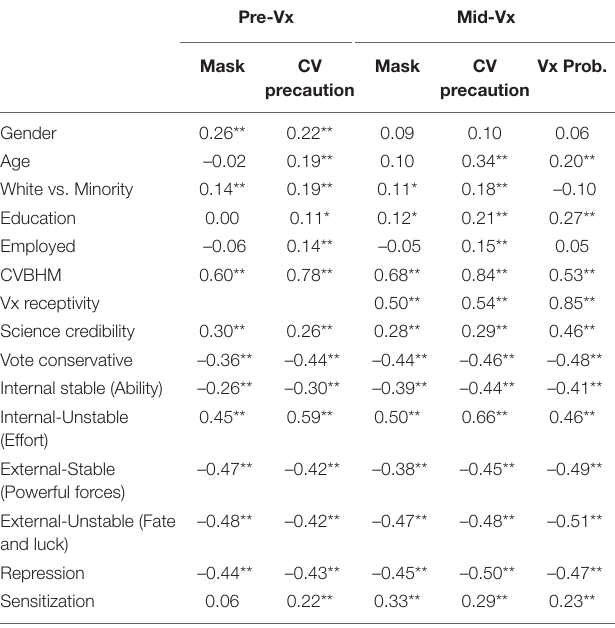
TABLE 5 | Correlations between demographic and psychological variables and COVID-related behaviors for pre-Vx and mid-Vx samples (Study 1). Pre-Vx Mid-Vx